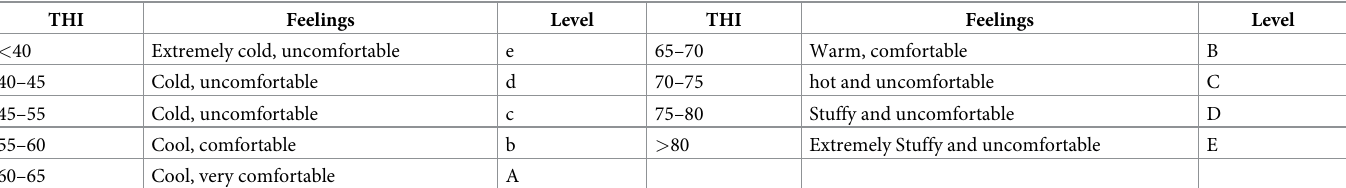
Table 2. Grade standard of moisture-temperature